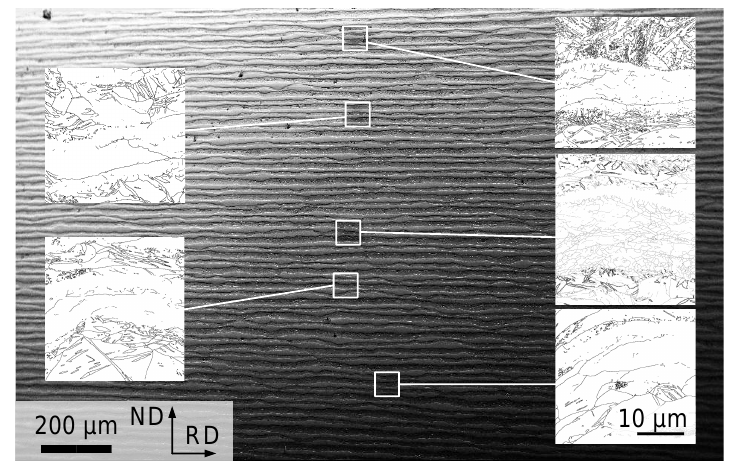
Figure 10. SEM micrograph showing the microstructure of a 160-layered Ti/Al composite obtained from six ARB cycles and subsequent differential speed rolling (three passes). The inserts show grain boundary maps at positions depicted. Lines indicate high angle grain boundaries including twin